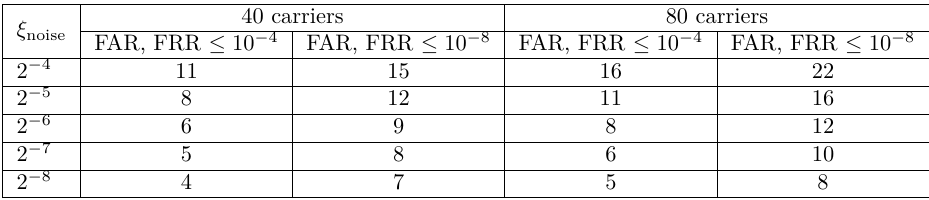
Table 1: Threshold τ rounds required for different levels of FAR and FRR when using 32-bit FDs under different number of